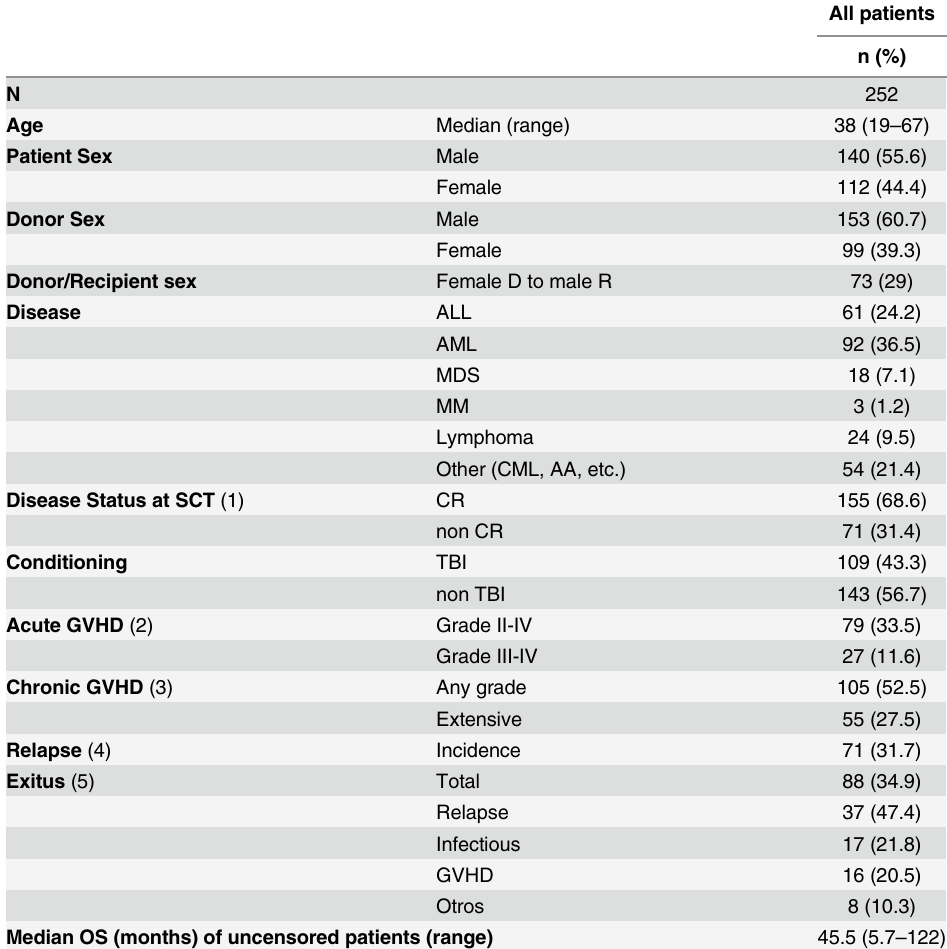
Table 1. Patients, SCT features and complications developed post-SCT in the patients included in the present study.